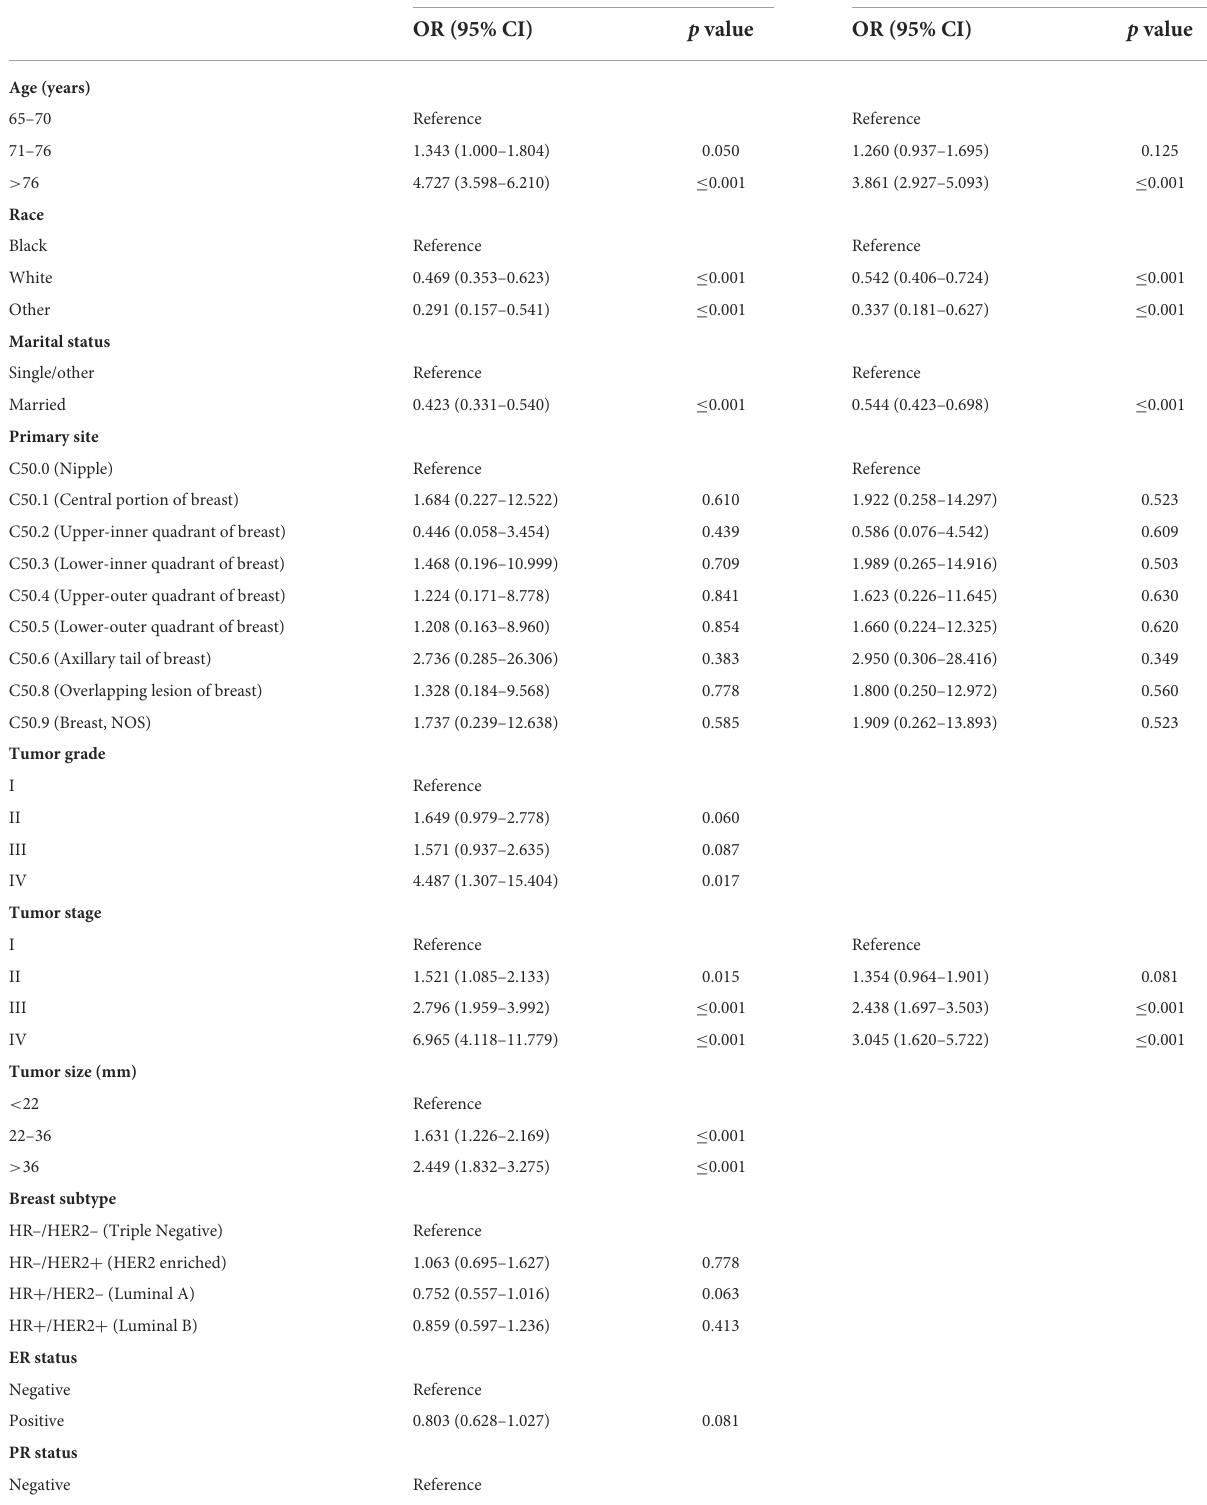
TABLE 2 The univariate and multivariate Cox regression analyses of the HDSS-related variables of older female primary breast cancer patients that underwent chemotherapy. Variables Univariate analysis Multivariate